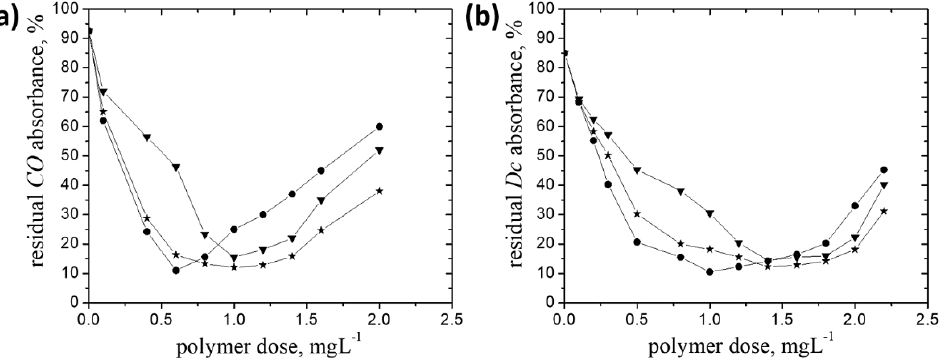
Figure 4. The residual pesticides absorbance (%) dependence on the polycation dose: P ₋ g ₋ pAPTAC1 (inverted triangle ), P ₋ g ₋ pAPTAC2 (star), P ₋ g ₋ pAPTAC3 (circle) for CO ( a ) and Dc ( b ); settling time 1200 min; c CO (%, w/w ) - 0.1; c Dc (%, v/v ) - 0.04, settling time 1200 min. 1200 min; c CO (%, w / w )—0.1; c Dc (%, v / v )—0.04, settling time 1200